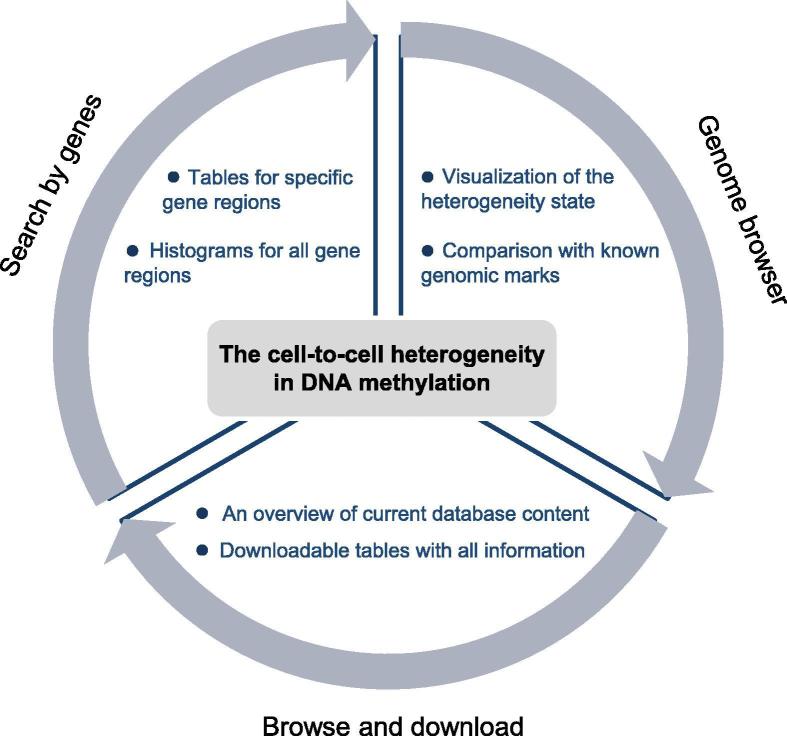
The functionality of HeteroMeth